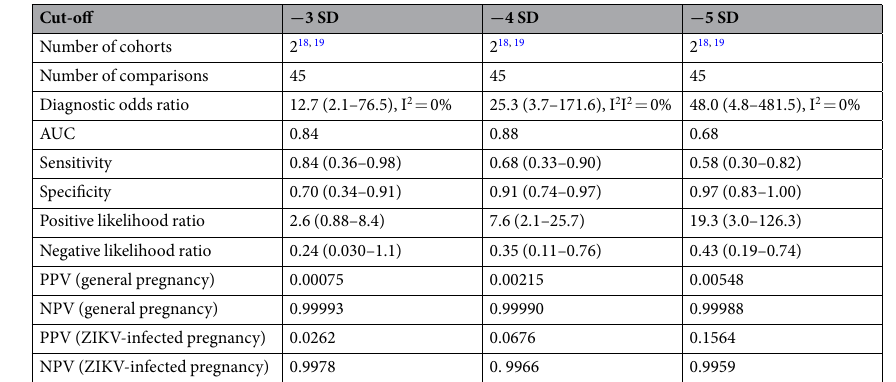
Table 4. Diagnostic accuracy of ultrasound measurements of head circumference for prenatal assessment of microcephaly. Parentheses indicate 95% CI. Pre-test probabilities, i.e. incidence of microcephaly among general pregnancies and ZIKV-infected pregnancies were estimated as 0.0285% and 0.95%,